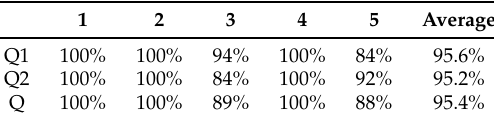
Table 9. Accuracy of five test